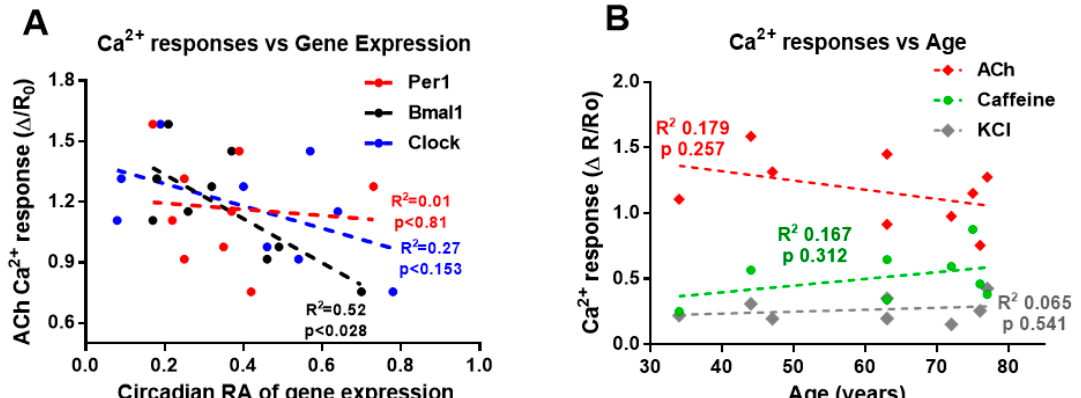
Figure 7. Ca 2 + signals are not associated to aging nor to clock genes expression in human colon muscle cells. Smooth muscle cells isolated from the muscle layer of the colon were loaded with fura-2 to determine changes in intracellular Ca 2 + concentration upon stimulation. ( A ) The average amplitude of the Ca 2 + responses (fold increase) to ACh 1 µM is plotted against the relative amplitude of the clock genes rhythm for each subject. The R2 and p for correlation is shown. Only ACh vs Bmal1 showed a significant negative relationship.. n = 10–71 cells from 9 individuals. ( B ) Relationship between age and Ca 2 + responses to ACh 1 µ M, ca ff eine 10 µ M and KCl 60 mM. Cells were averaged for each stimuli and individual. n = 9–26 cells for KCl, 5–22 cells for ca ff eine and 10–71 cells for